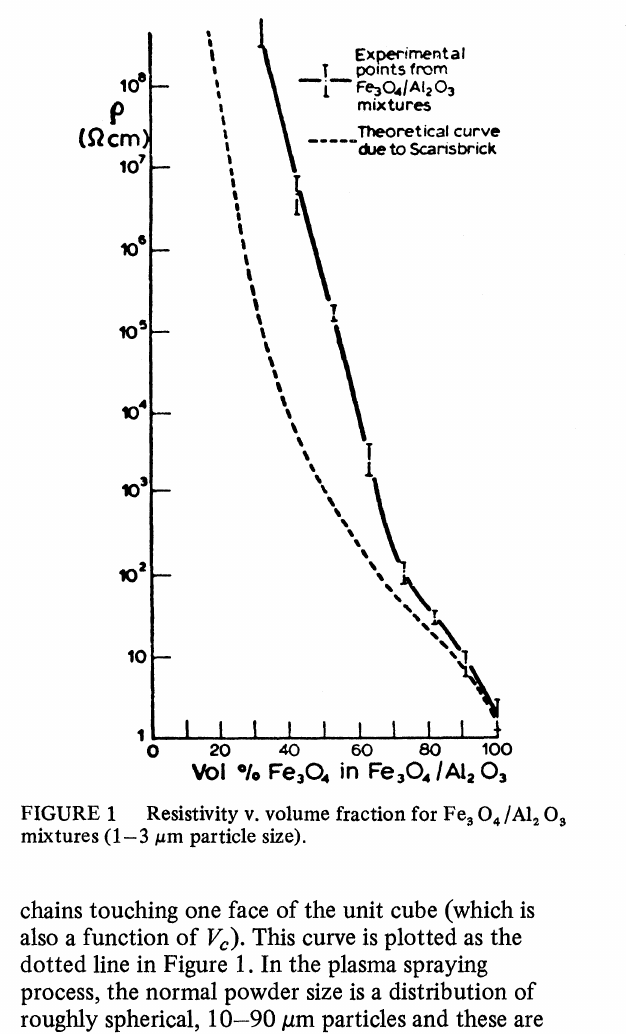
FIGURE 1 Resistivity v. volume fraction for F% O4/A12 O mixtures (1- 3 um particle size).